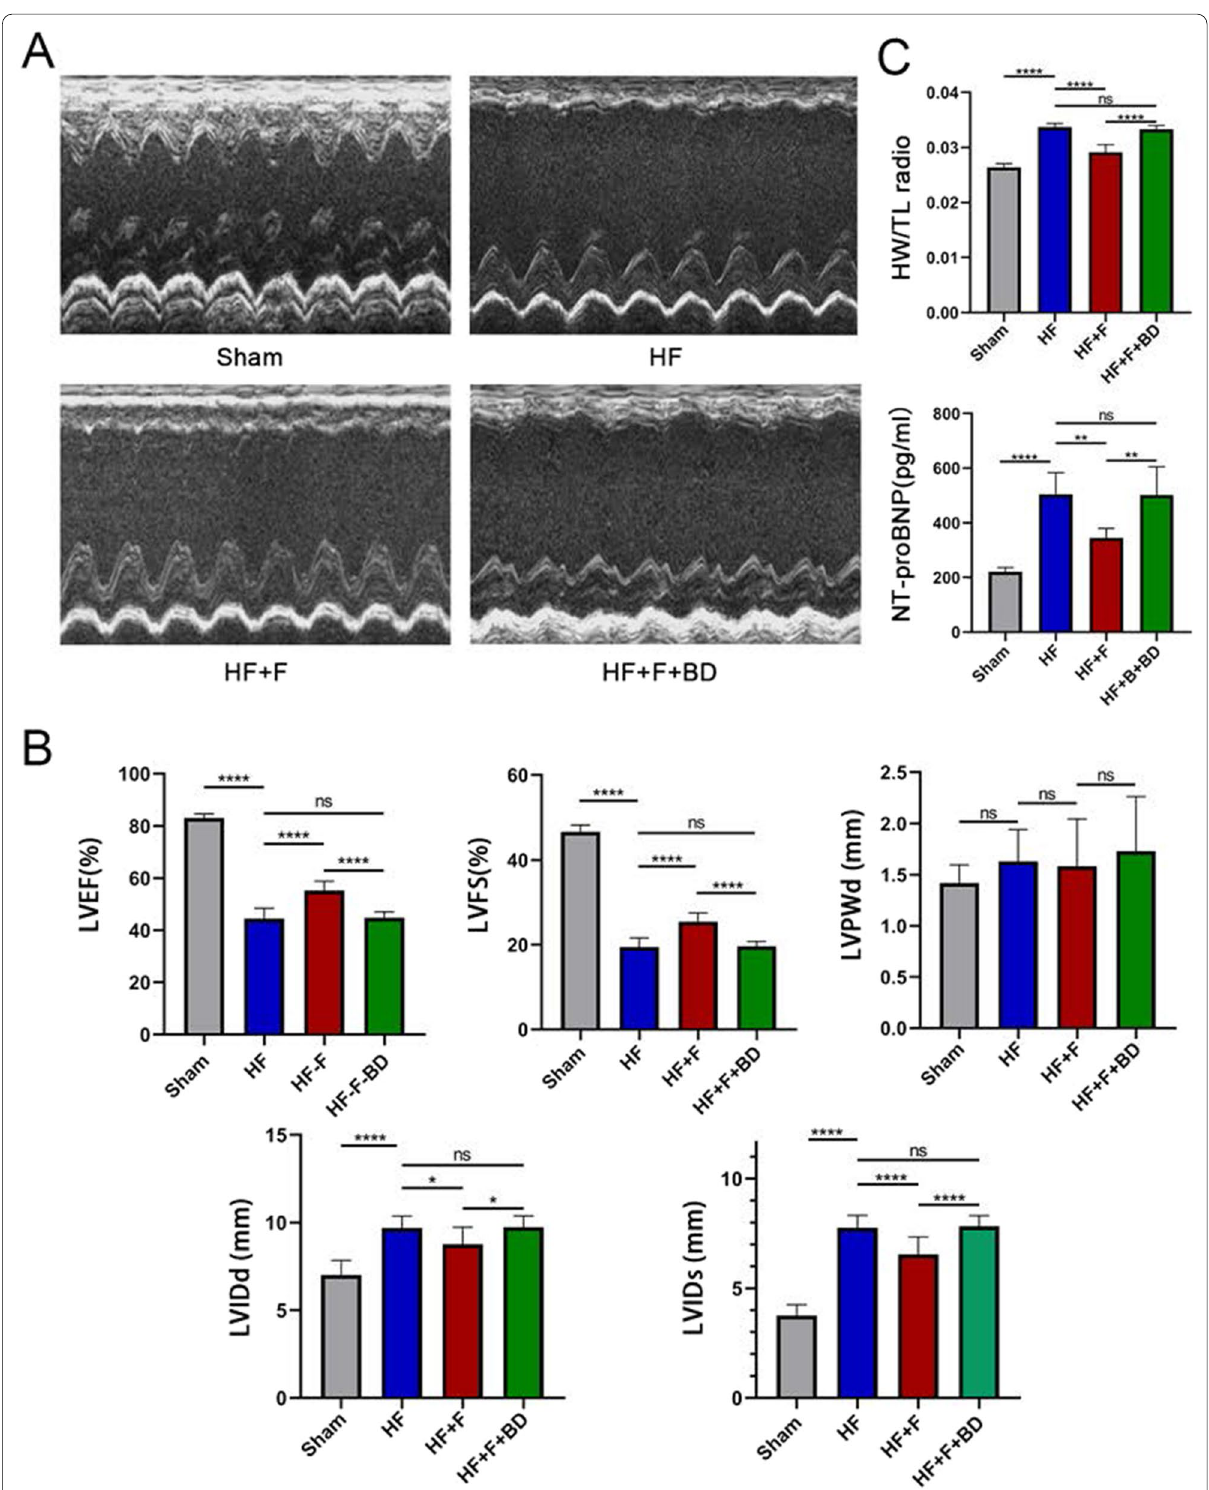
Fig. 1 The effects exerted by chronic stimulation of the sigma-1 receptor on cardiac functions. A Representative M-mode echocardiogram images in all groups; B Serum BNP concentration and heart weight/tibial length, reflecting the severity of heart failure and cardiac hypertrophy; C Statistical analysis of parameters relative to cardiac function; *P < 0.05; **P < 0.01; ***P < 0.005; ****P <